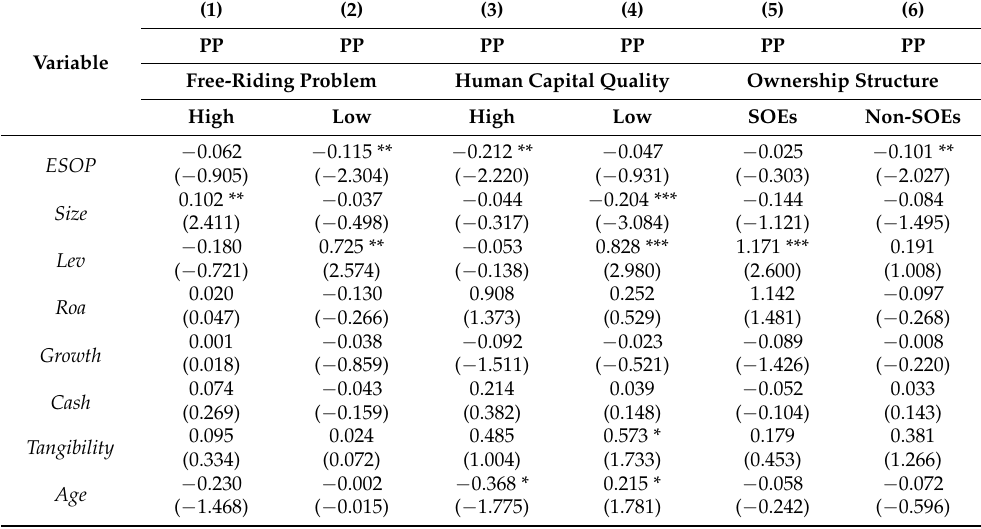
Table 6. Cross-sectional